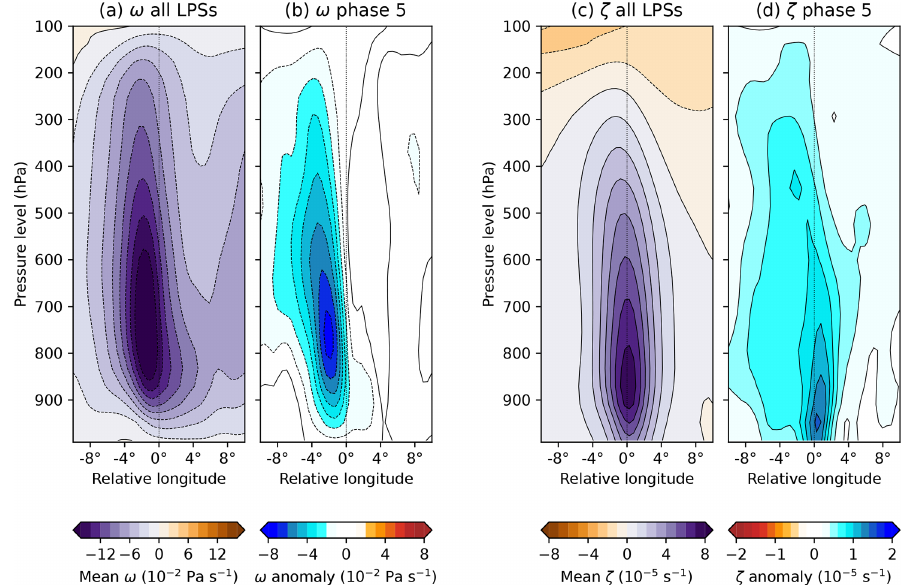
Figure 12. Zonal-vertical cross-section through system-centred composite means of ω (a, b) and relative vorticity (c, d) . For each variable, the mean for all LPSs is given on the left (a, c) , and the anomaly for LPSs occurring during BSISO phase 5 is given on the right (b, d) . Computed for monsoon LPSs north of 15 ◦ N. Cross-sections are taken as an average from 1 ◦ S to 1 ◦ of the central latitude. Data from levels below surface pressure have been excluded.